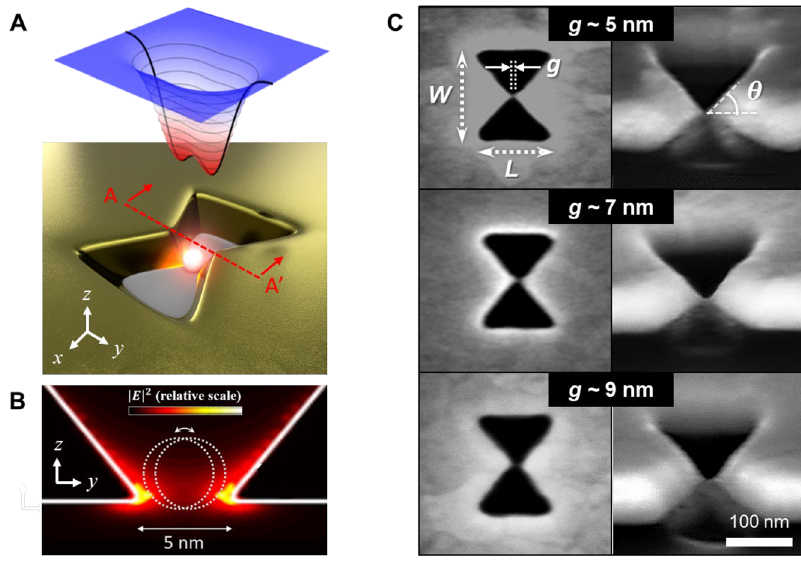
Figure 1: 3D plasmonic nanoantenna.